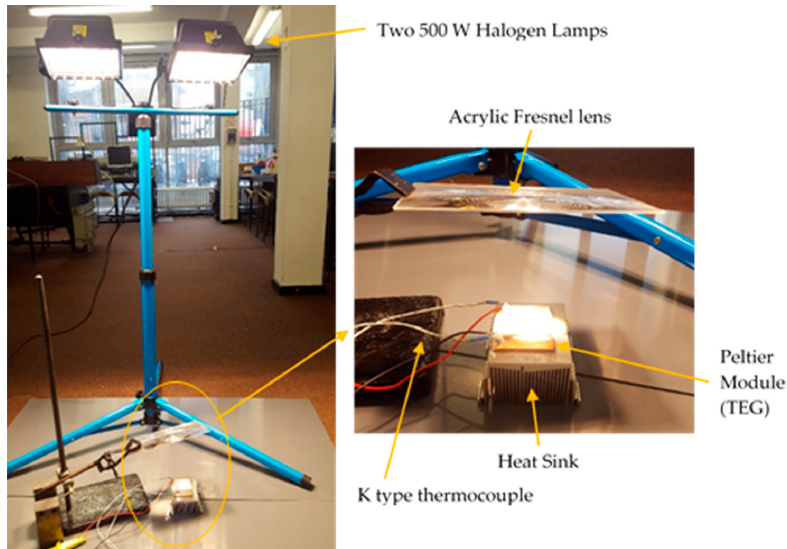
Figure 7. Photographs of the experimental setup for the concentrated quartz-halogen (two 500 W lamps) radiative heat harvesting using Fresnel lens with Peltier module.